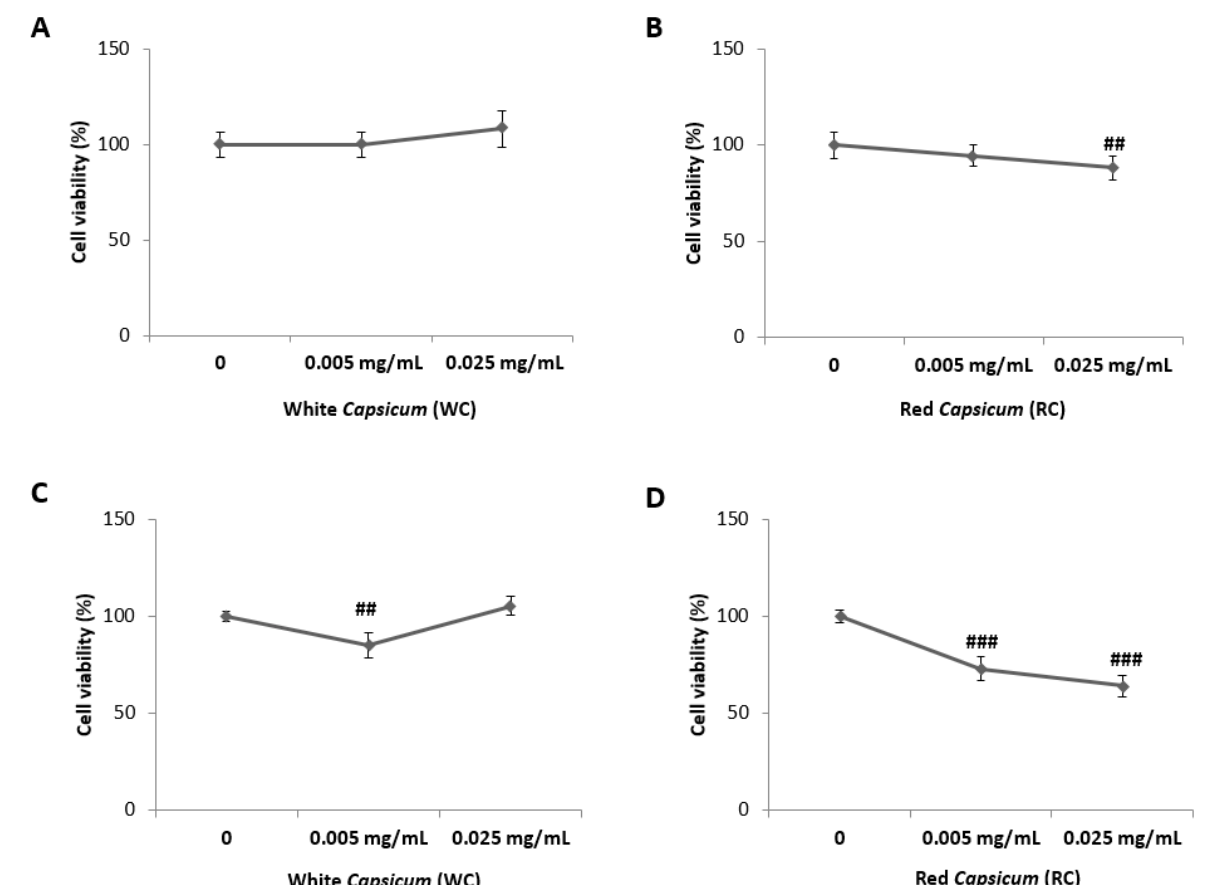
Figure 2. Effect of WC and RC on U937 ( A , B ) and HEK293 ( C , D ) cells’ viability. U937 and HEK293 cells were treated with WC or RC (0.050 mg/mL and 0.025 mg/mL) as indicated for 72 h. Cell viability was measured using an MTT assay or a Millipore Scepter™ handheld automated cell counter. Results are presented as means ± SDs from three independent experiments. ### p < 0.001, ## p < 0.01 versus control (one-way analysis of variance, ANOVA followed by Student’s t -test for multiple comparisons).